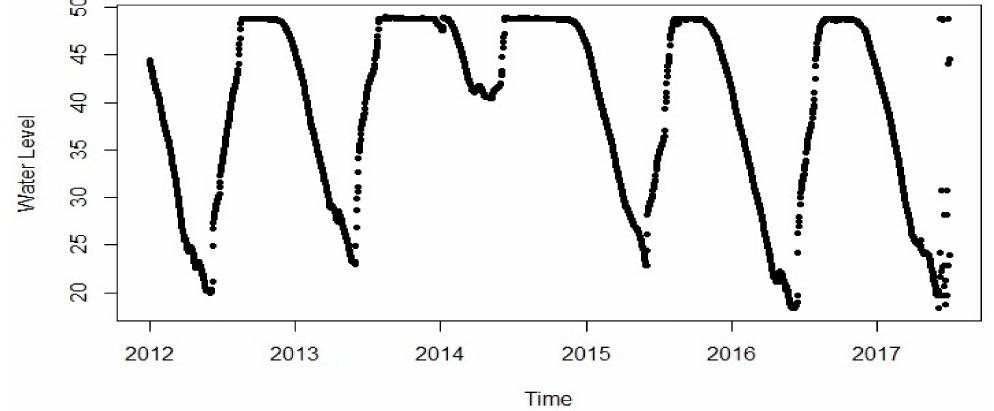
Figure 13. Roode Elberg water level 2012–2017 (water level in metres(m)). Variable